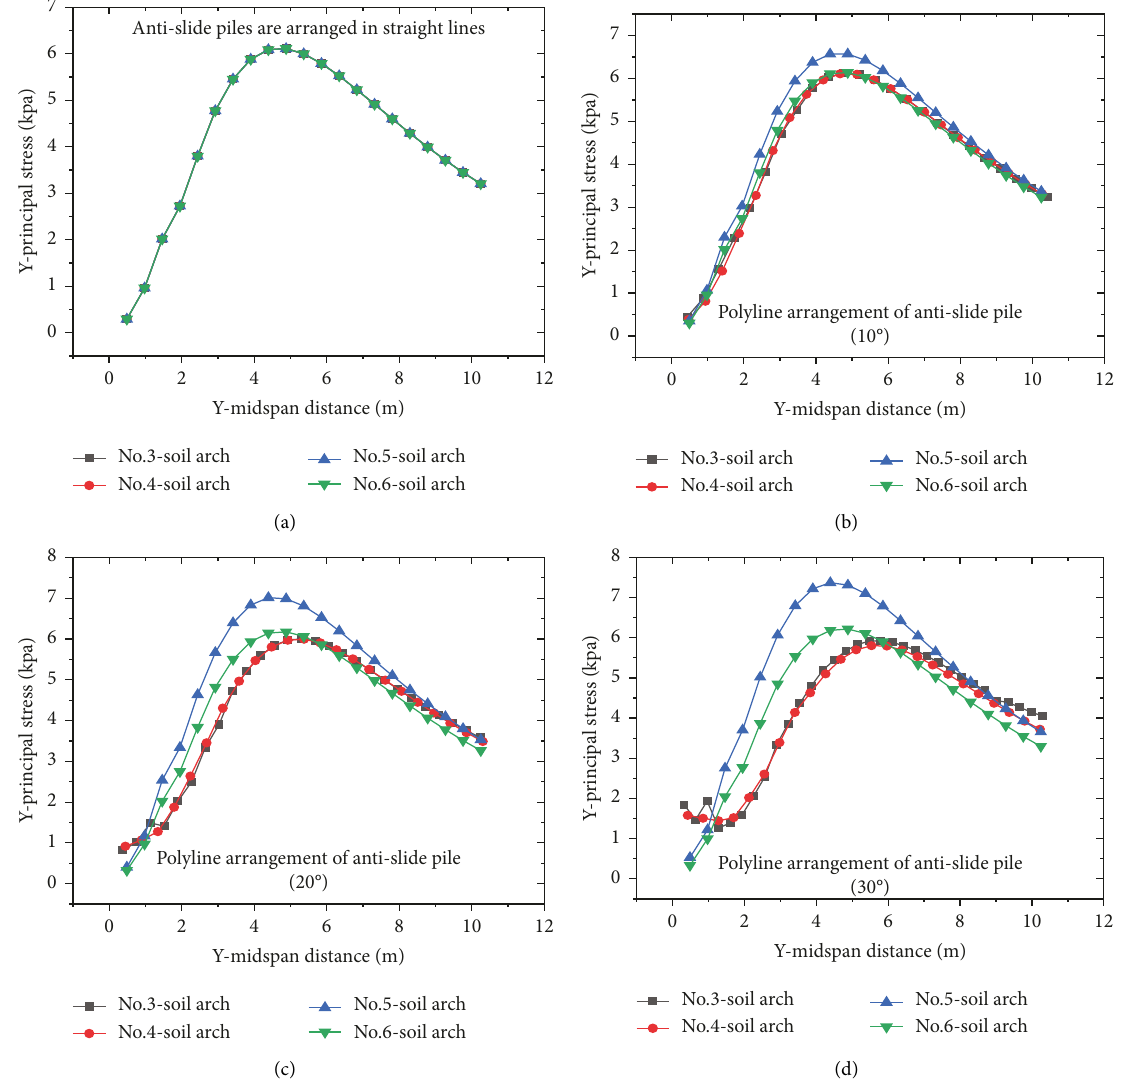
Figure 11: Comparisons among principal stress curves in the Y